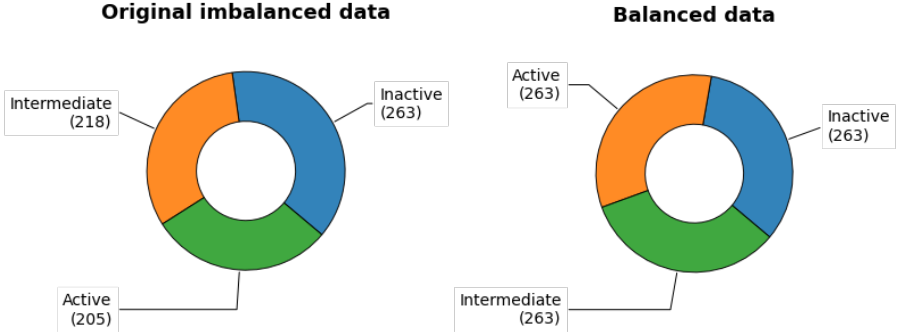
Figure 2: Schematic comparison of original and balanced